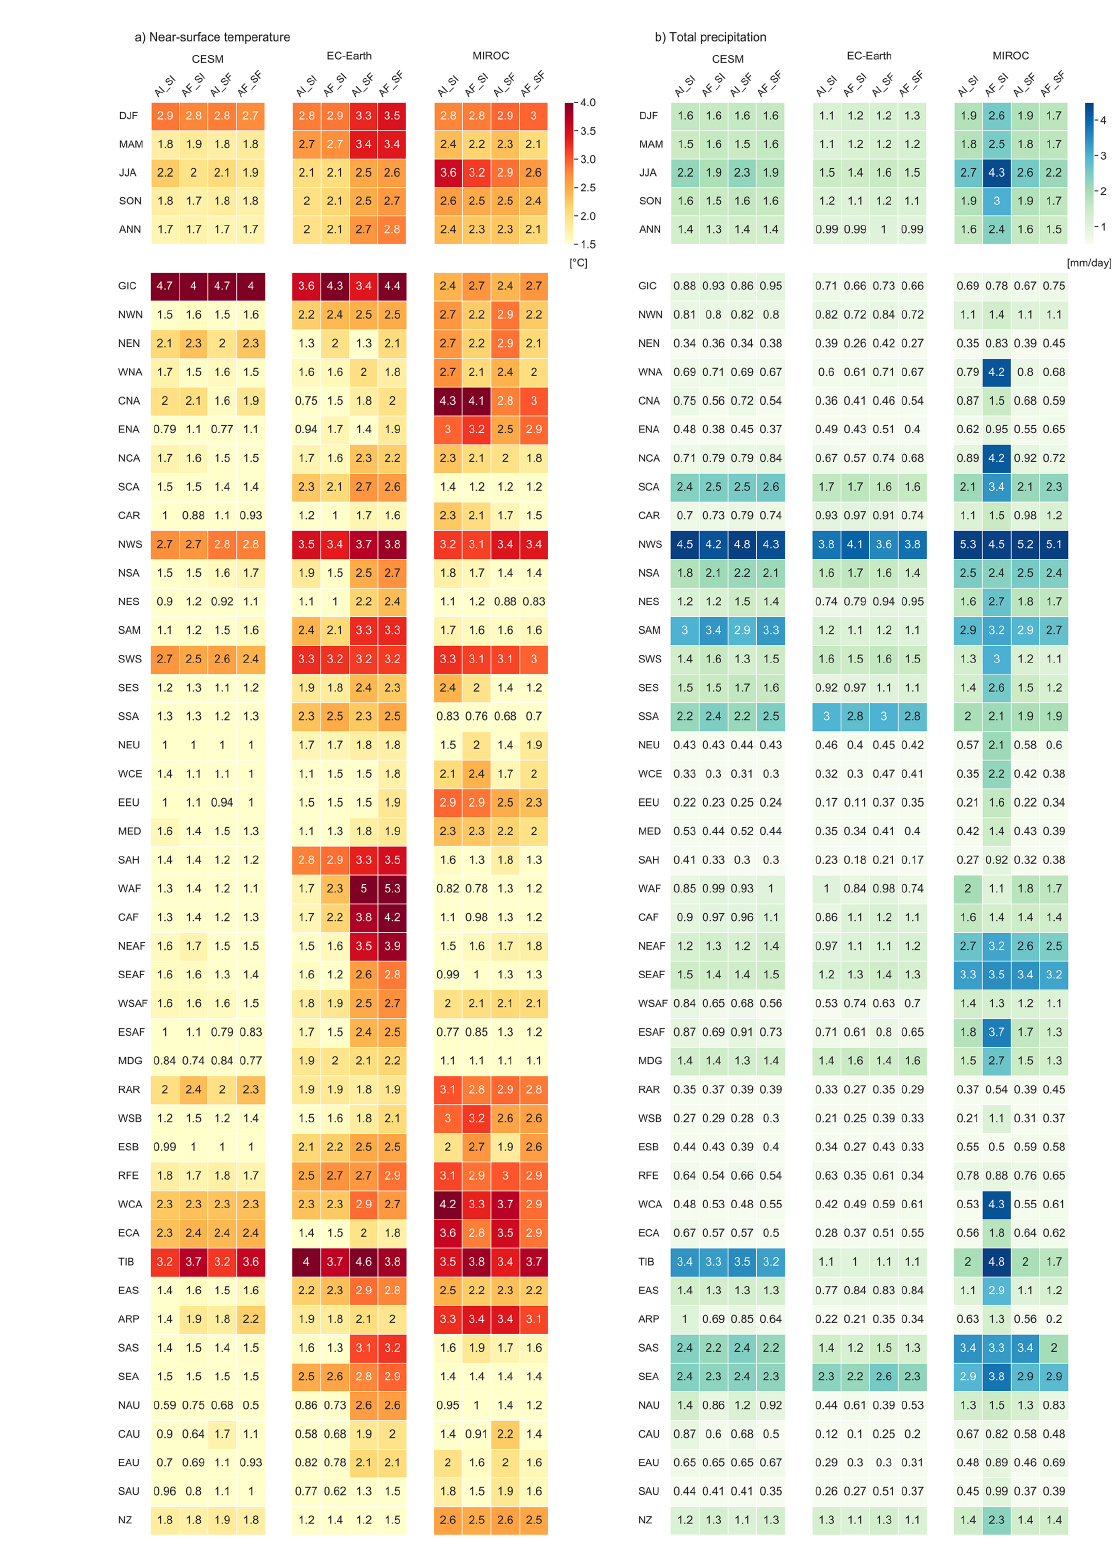
Figure 3. Root mean square errors (RMSEs) for (a) near-surface temperature and (b) total precipitation. The top section shows the global RMSE for land grid points as well as seasonal and annual (ANN) averages. The bottom section shows the average annual RMSE for the reference regions from the Sixth Assessment Report (AR6) on climate change (Iturbide et al., 2020). For an overview of the AR6 reference regions see Fig. A3. Ocean grid points and Antarctica are